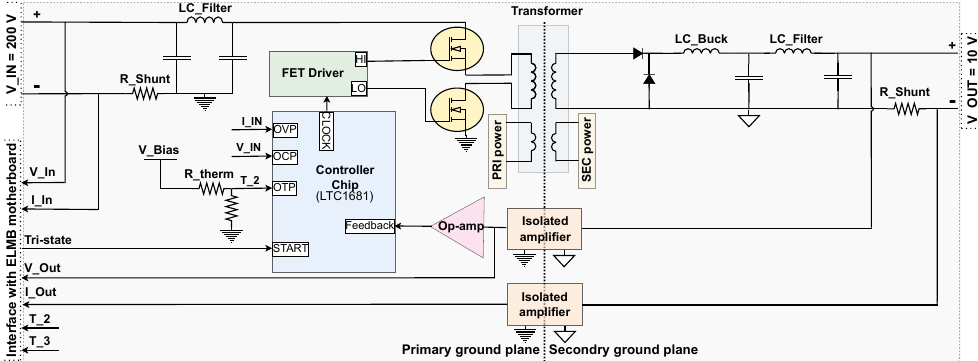
Figure 4. Thermal image of a V8.4.2 LVPS Brick undergoing burn-in ( Left ). Thermal image of a V8.4.2 LVPS Brick undergoing burn-in highlighting the use of an external thermocouple ( Right ).